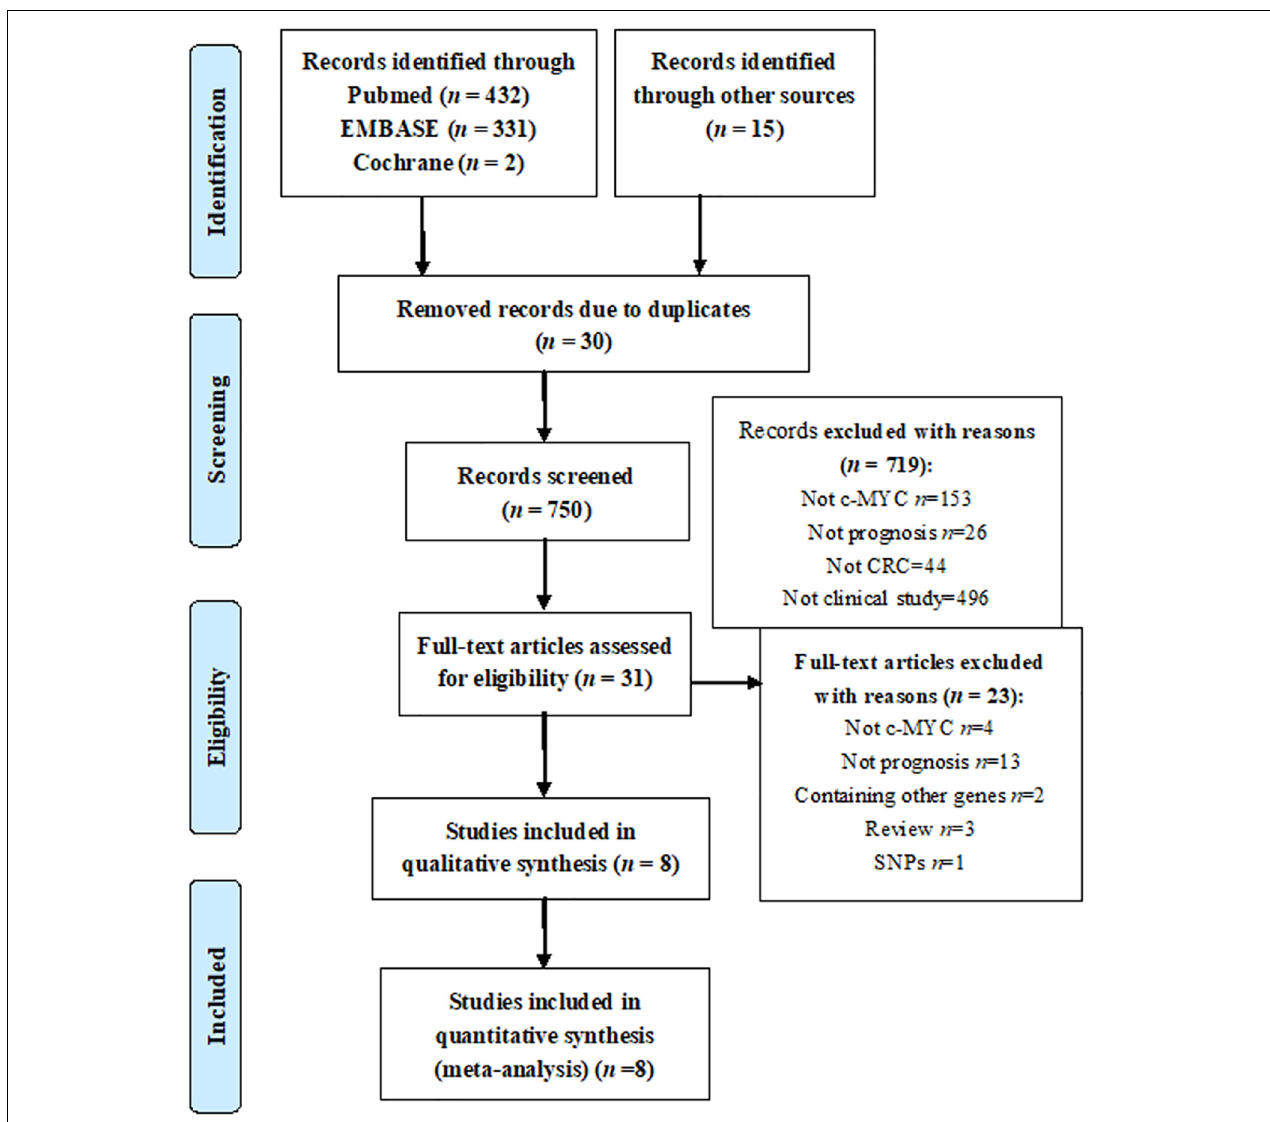
FIGURE 1 | Flow chart of the literature search and study